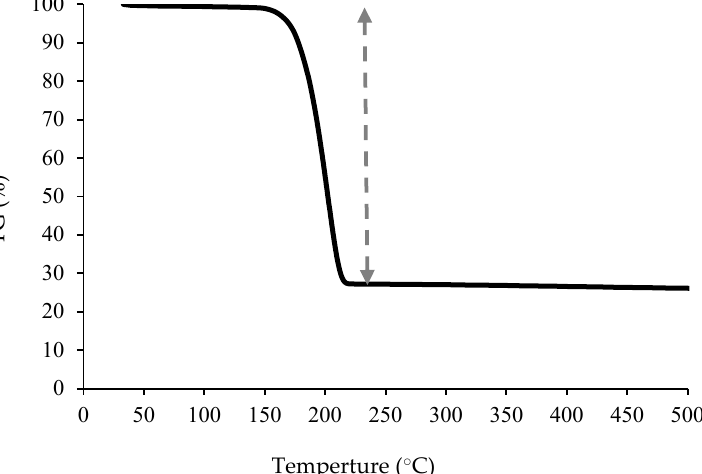
Figure 3. TGA ‐ DTA analysis of the thermal decomposition of the Ni (S 2 CO(CH 2 ) 4 CH 3 ) 2 complex into pure NiS nanopowder.